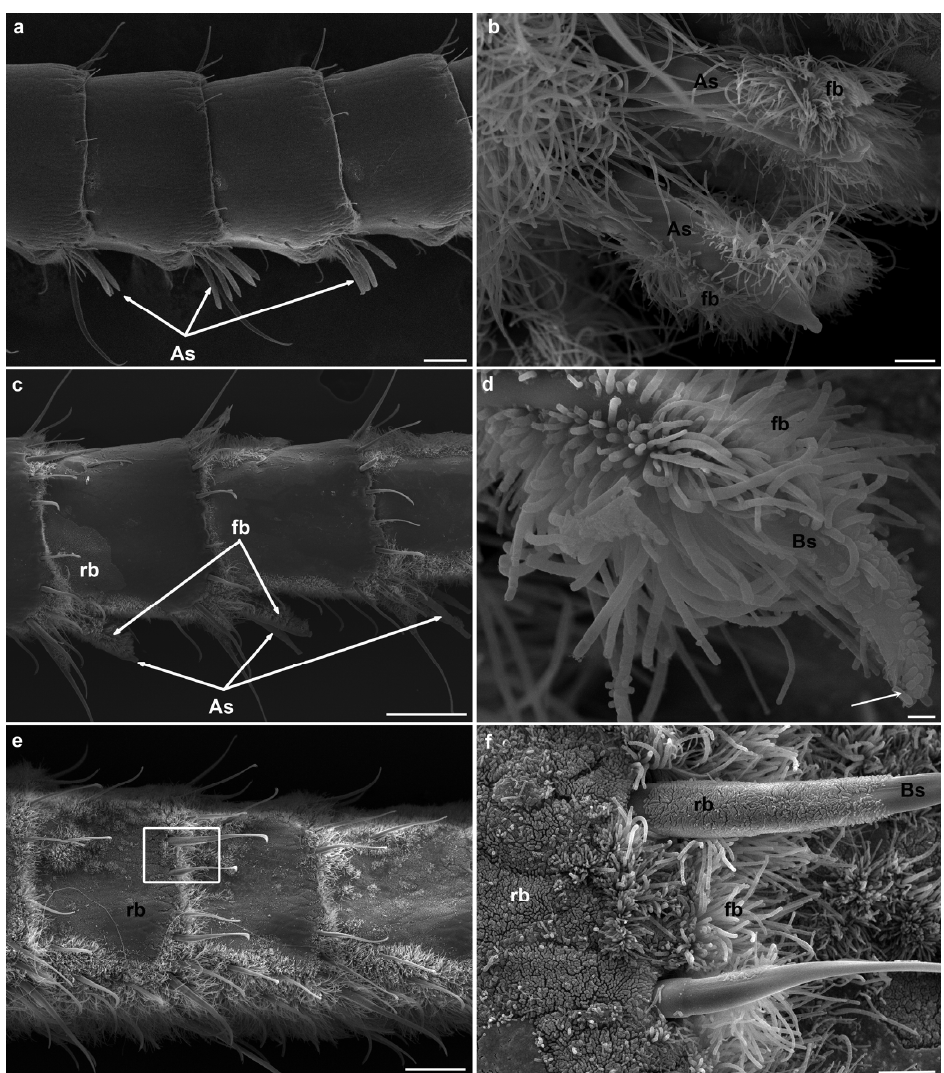
Figure 8. Scanning electron micrographs of Rimicaris exoculata before (Rex1, Rex5) and after (Rex38) grooming experiments. ( a , c , e ) Antennules of Rex1 ( a ), and Rex5 ( c , e ) specimen showing gradation from no, light and high bacterial fouling on the antennal segments; ( b , d , f ) Antennule of Rex38 specimen showing dense bacterial fouling on the aesthetascs ( b ) and beaked setae ( d , f ) (terminology used in [23]) including their terminal pore. In ( d ) arrow shows the location of the pore covered by rods). Frame in ( e ) is enlarged in ( f ), showing the bacterial (rods) mat covering the surface of the segments, the filamentous bacteria (fb) in the inter-segmental areas and the base of a short thin setae, as well as and an intermediate beaked setae covered by rod-shaped bacteria. As: aesthetascs, Bs: beaked seta, fb: filamentous bacteria, rb: rod-shaped bacteria. Scale bars: ( a , c , e ) = 100 μ m; ( b , f ) = 10 μ m; ( d ) = 2 μ m.